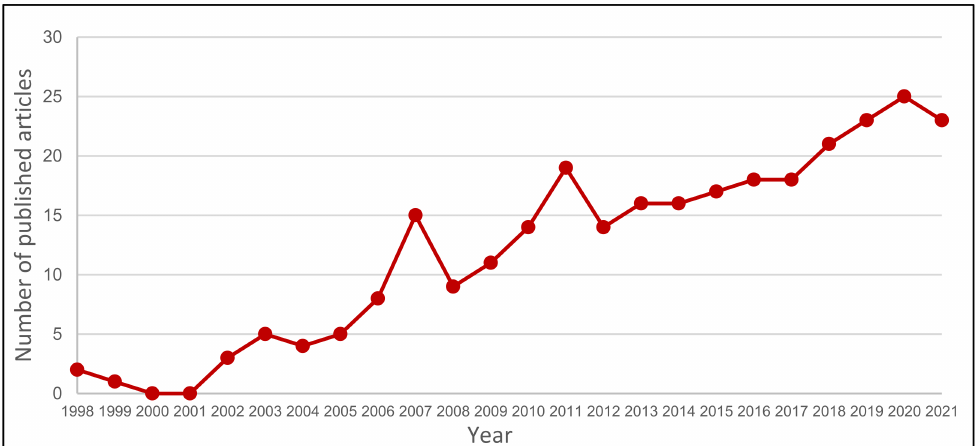
Figure 1. Number of published articles between 1998 and 2022 related to